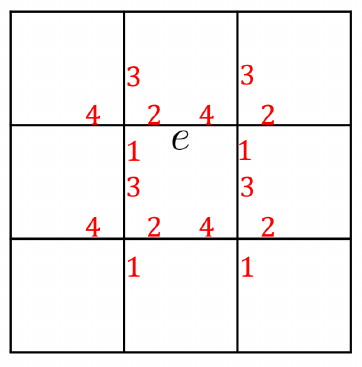
FIG. 11. The ordering of edges on each vertex. The red num- bers are the labels. Note that one edge is connected to two vertices, and the two numbers on the two vertices do not need to be the same. The assigned numbers determine the relative ordering for two edges connecting to the same